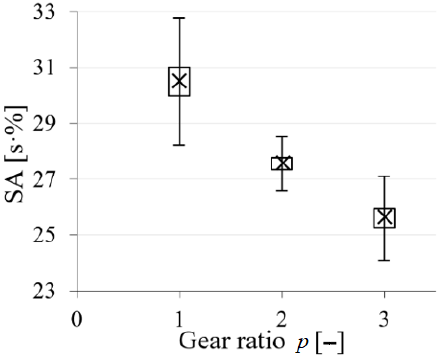
Figure 8. Average values of the area under the diagram (SA) for measurement tests s2, k1-3 and p1- 3 for the muscle: extensor carpi radialis longus (D); error bars are ± standard deviation.